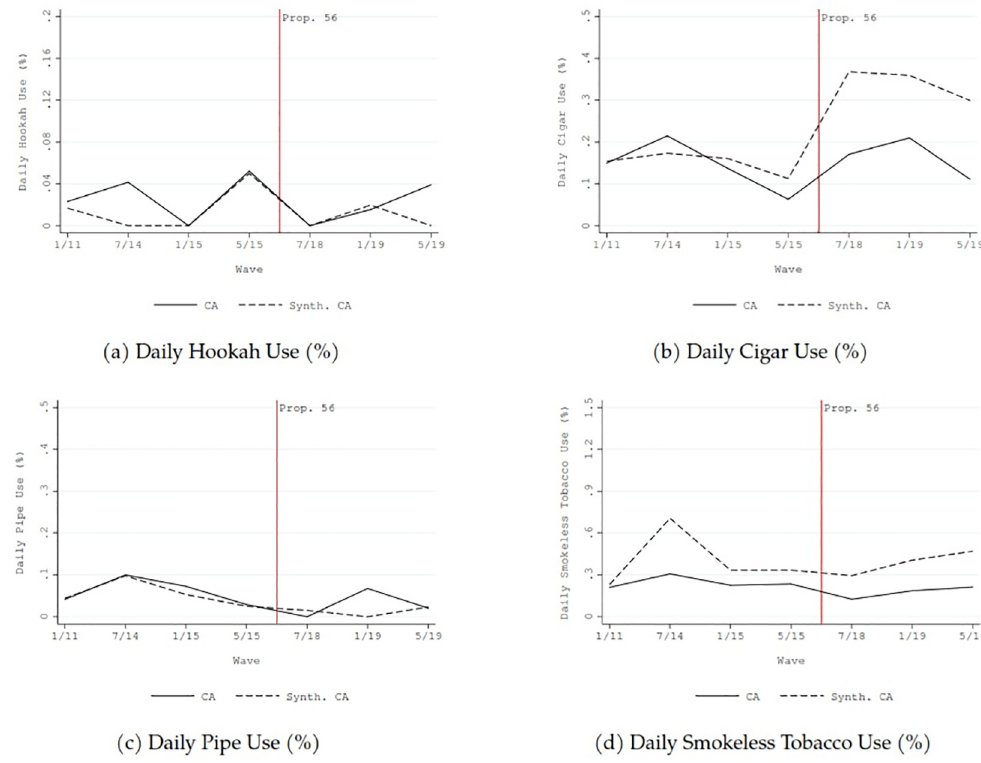
Fig 4. Comparison before and after the implementation of California Proposition 56 tobacco tax increase between California and synthetic control: Non-cigarette tobacco use outcomes—daily use (%). https://doi.org/10.1371/journal.pone.0257553.g004 Table 1. Descriptive statistics of predictor variables in California and synthetic control: Cigarette price and use outcomes. Cigarette Price Current Cigarette Use Daily Cigarette